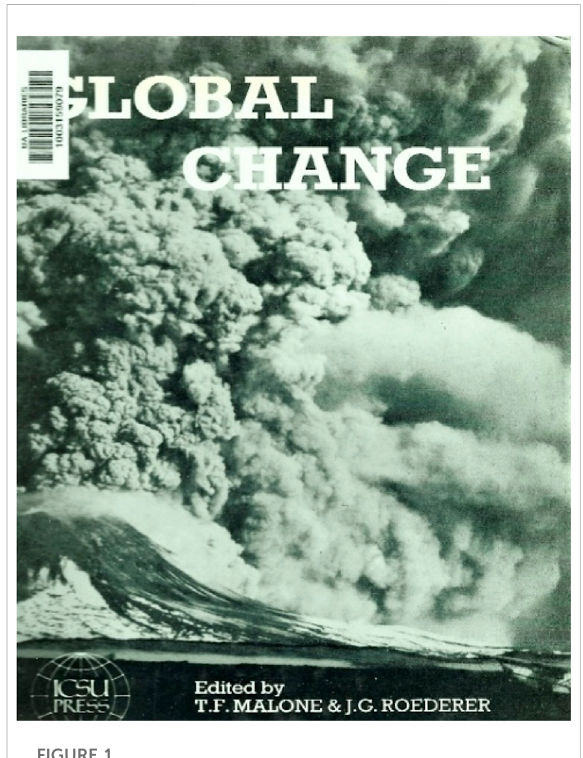
FIGURE 1 Cover of the fi rst edition of the book (Malone and Roederer, 1985)with all contributions to the1984 Ottawa Symposium onthe IGBP. The picture of the eruption of Alaska ’ s St. Augustine volcano was chosen on purpose to emphasize the original global interdisciplinary character envisaged for the original